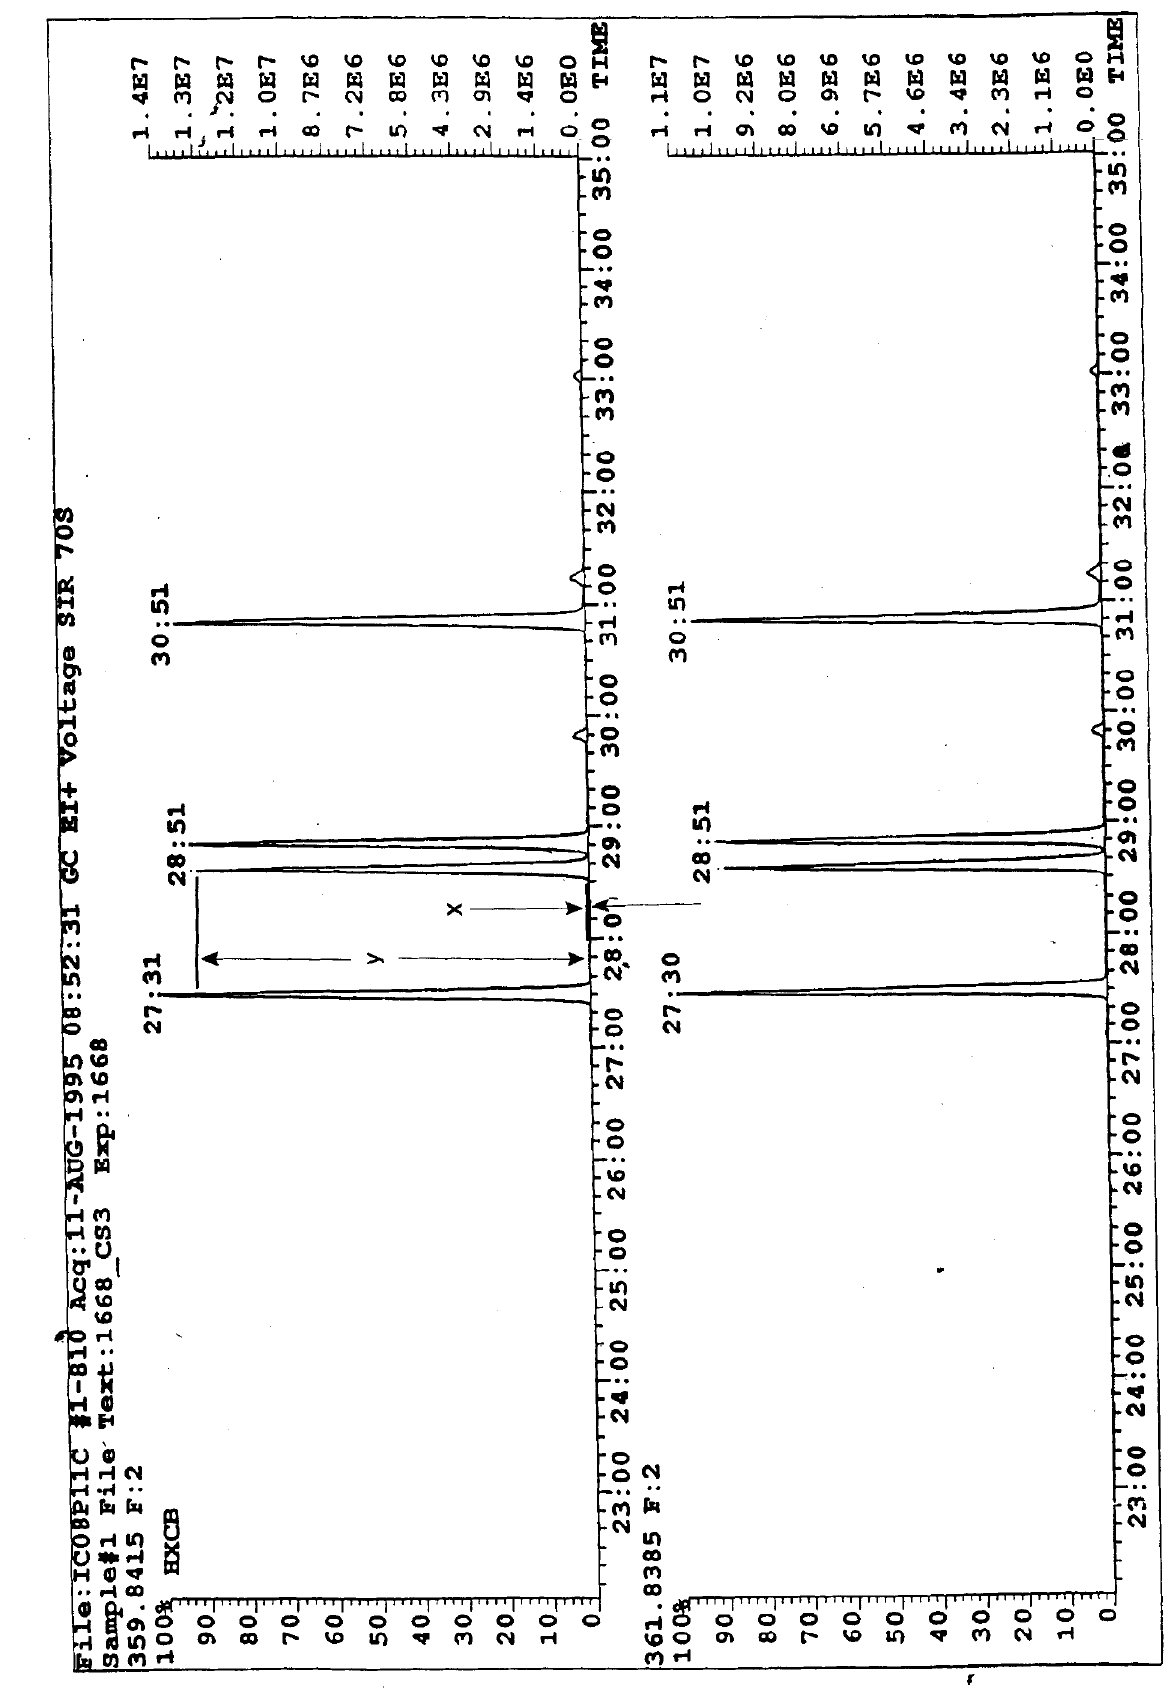
Figure 7 Congener-SpecificSseparation of PCBs 156 and 157 on DB-1